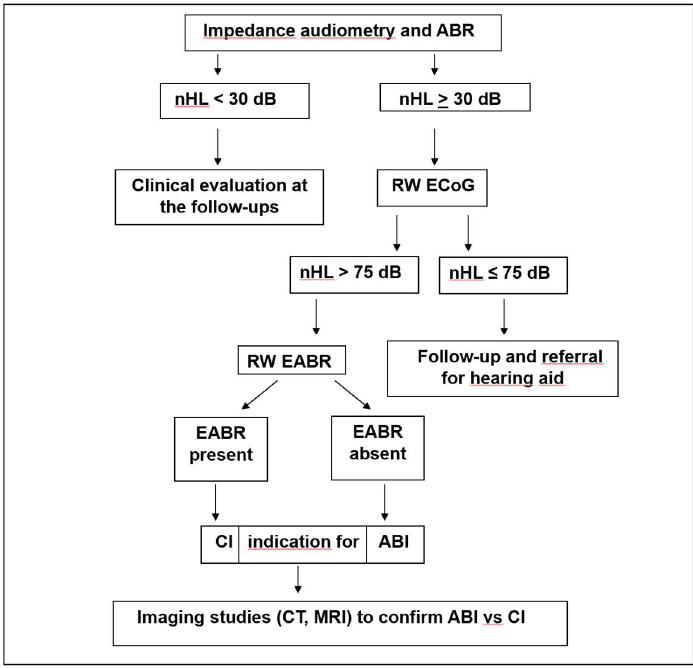
Scheme 1. Flow chart of testing children in a single